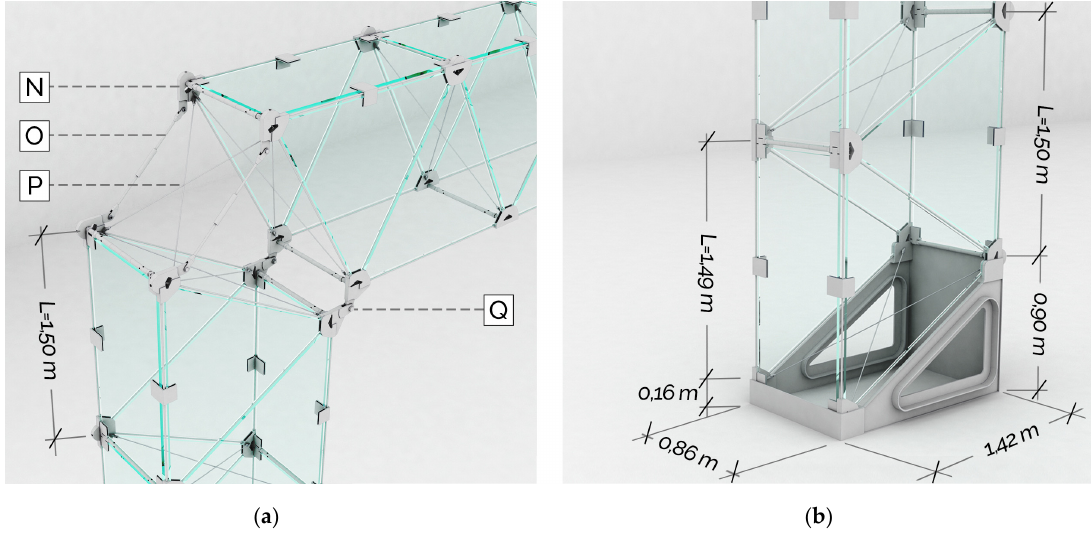
Figure 6. TVT γ‐ bis frame portal joints ( a ) beam ‐ to ‐ column joint and ( b ) column ‐ to ‐ base joint: N) Figure 6. TVT γ -bis frame portal joints ( a ) beam-to-column joint and ( b ) column-to-base joint: Extreme node of the beam; O) fork ‐ end steel bars with steel sleeve for regulation; P) cross bracing N—Extreme node of the beam; O—fork-end steel bars with steel sleeve for regulation; P—cross strands; Q) a finger joint connection with a M24 linchpin. bracing strands; Q—a finger joint connection with a M24